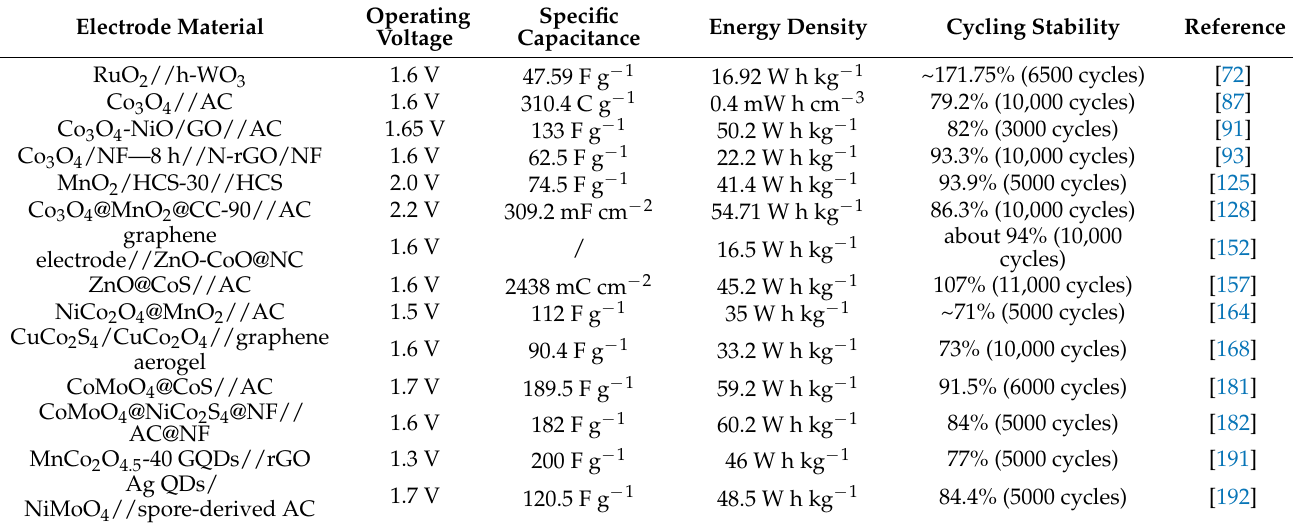
Table 3. The performance of supercapacitors based on binary and ternary